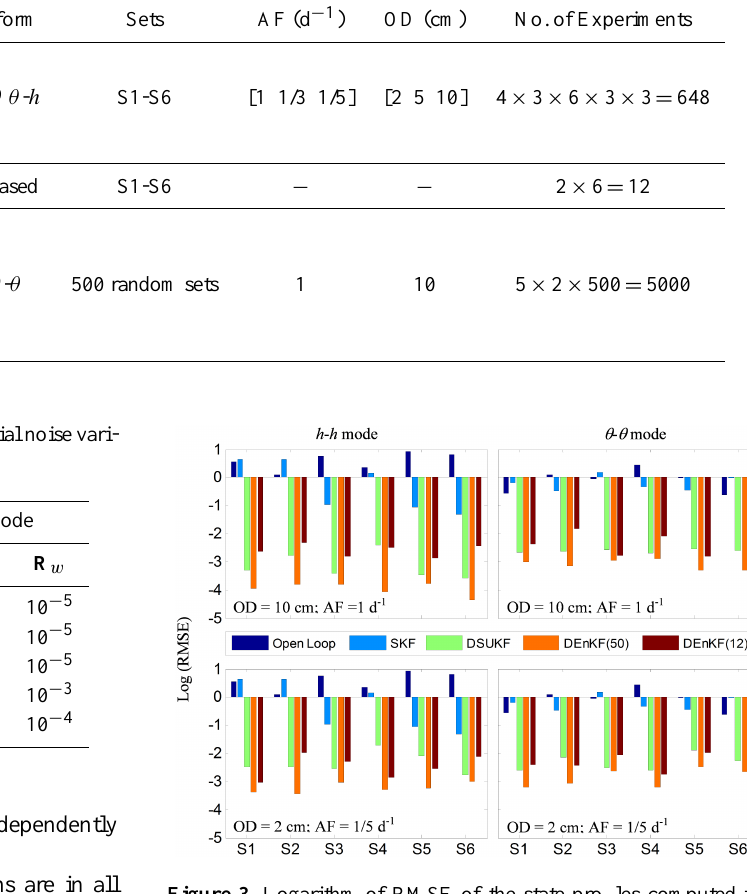
Figure 3. Logarithm of RMSE of the state profiles computed for open loop simulations, SKF, DSUKF, DEnKF(50) and DEnKF(12), in the h - h (left column) and in the θ - θ (right column)